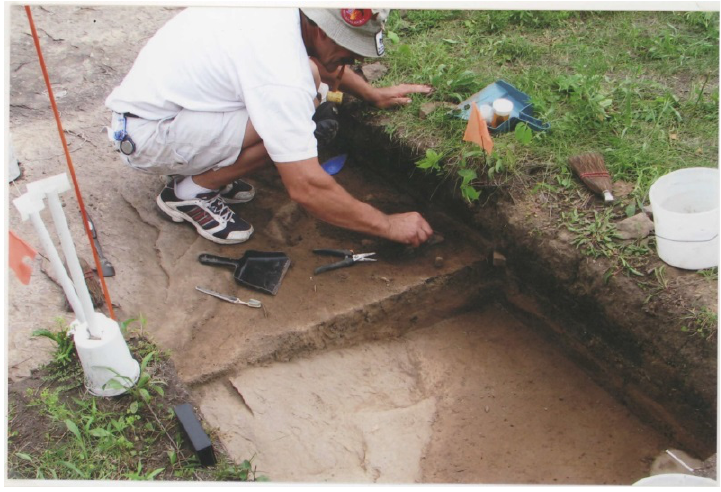
Figure 5. Excavating down to the Aeolian zone. Except for root snips, metal tools are not used in the Hensler excavations. Excavator is Glen Oechsner. Photo by